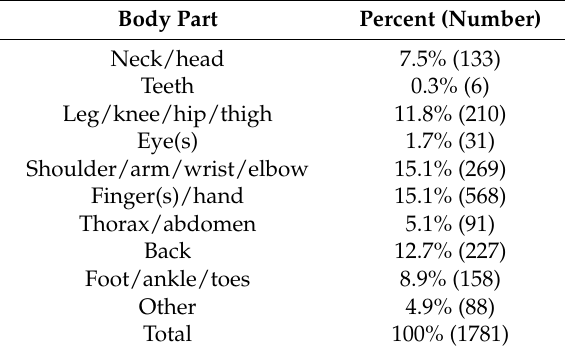
Table 6. Injured body parts of fishermen in the period 1998–2016.